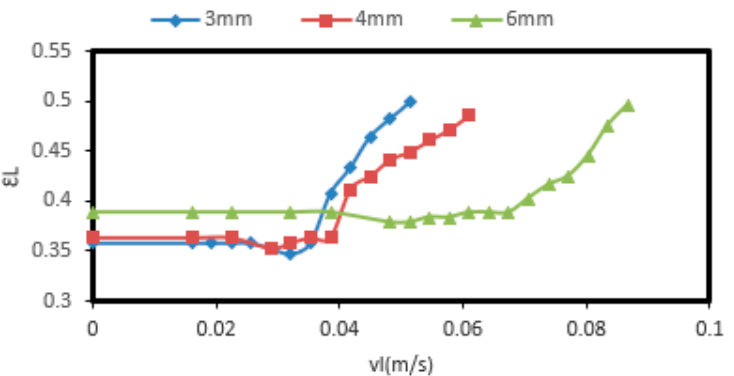
Figure 7. Variation liquid holdup with liquid velocity for various particle diameters.